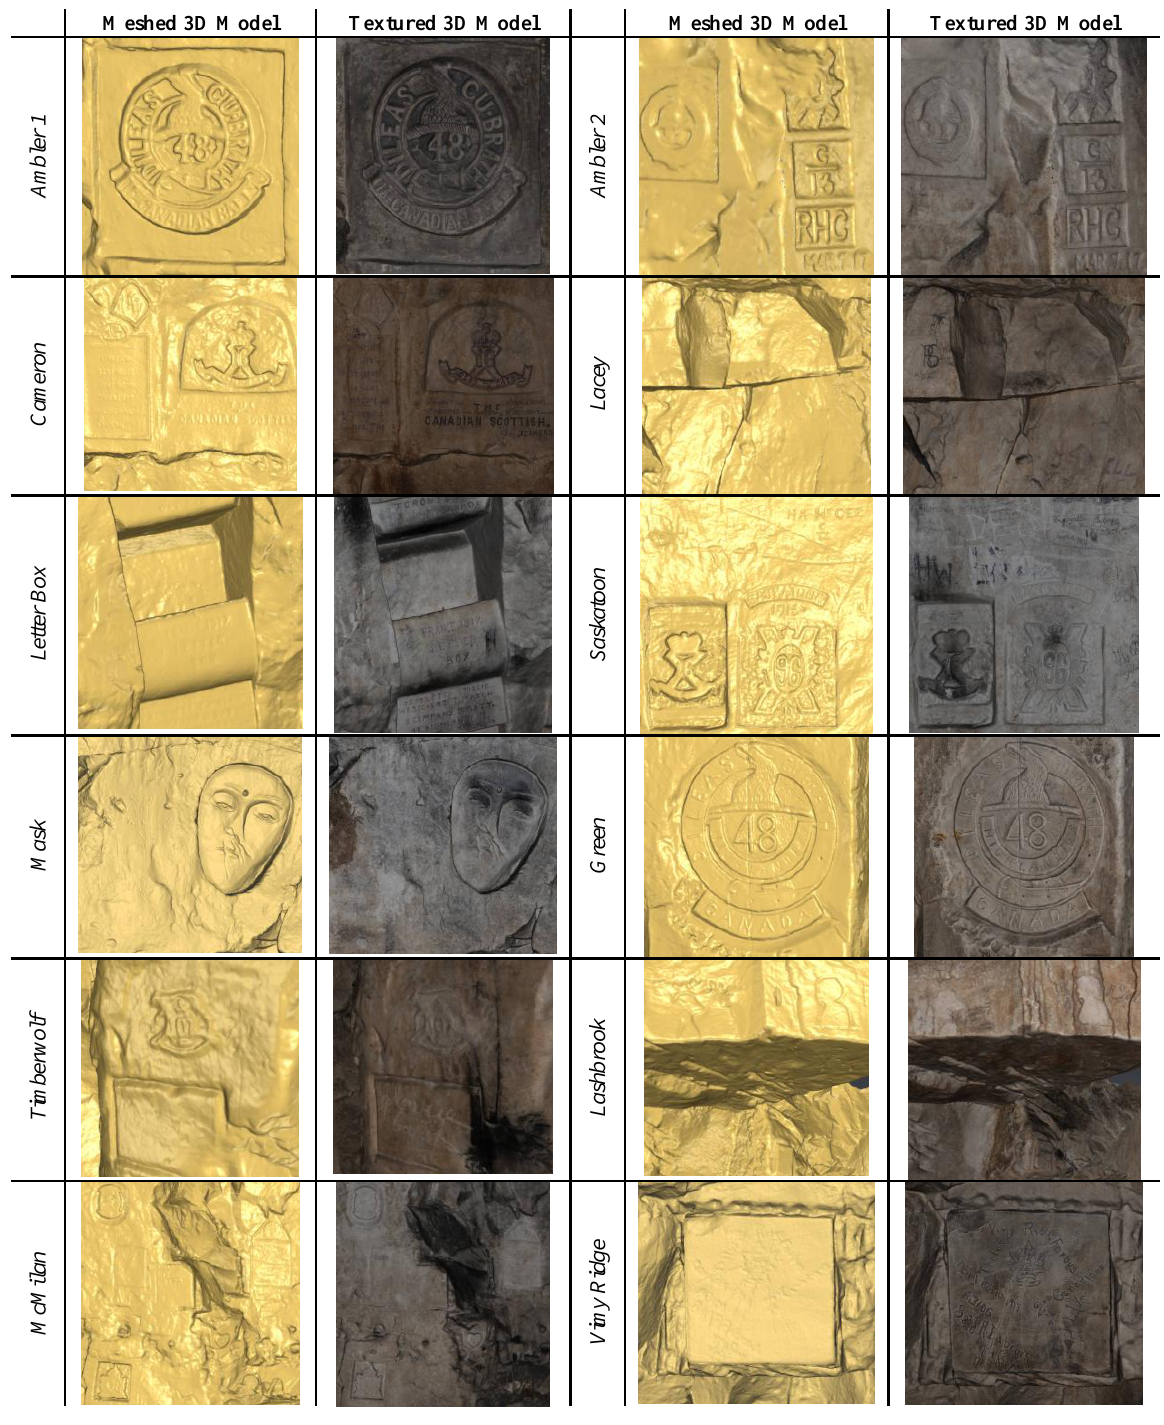
Table 2. Screenshots of the results of the photogrammetric